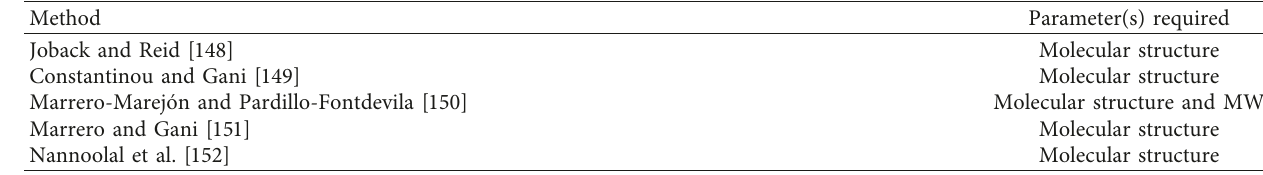
Table 3: Methods for the normal boiling point estimation.